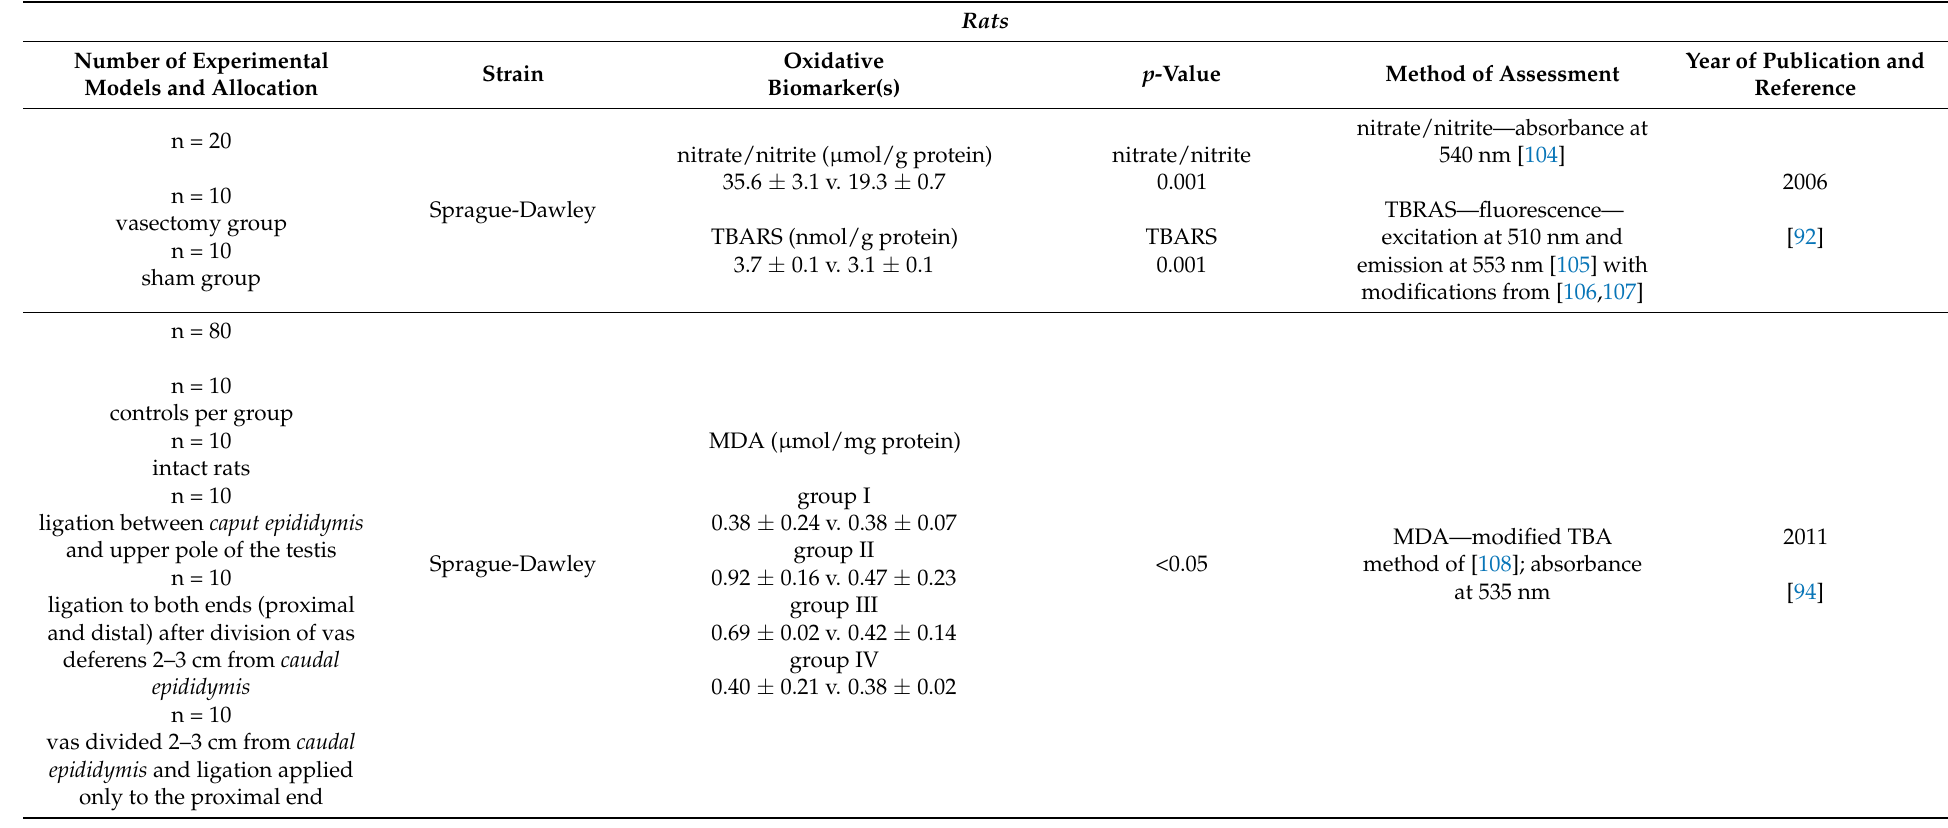
Table 2. Stratification of studies per year of publication based on design, allocation, and strain with the main results that highlight changes in oxidative stress biomarkers in rats and